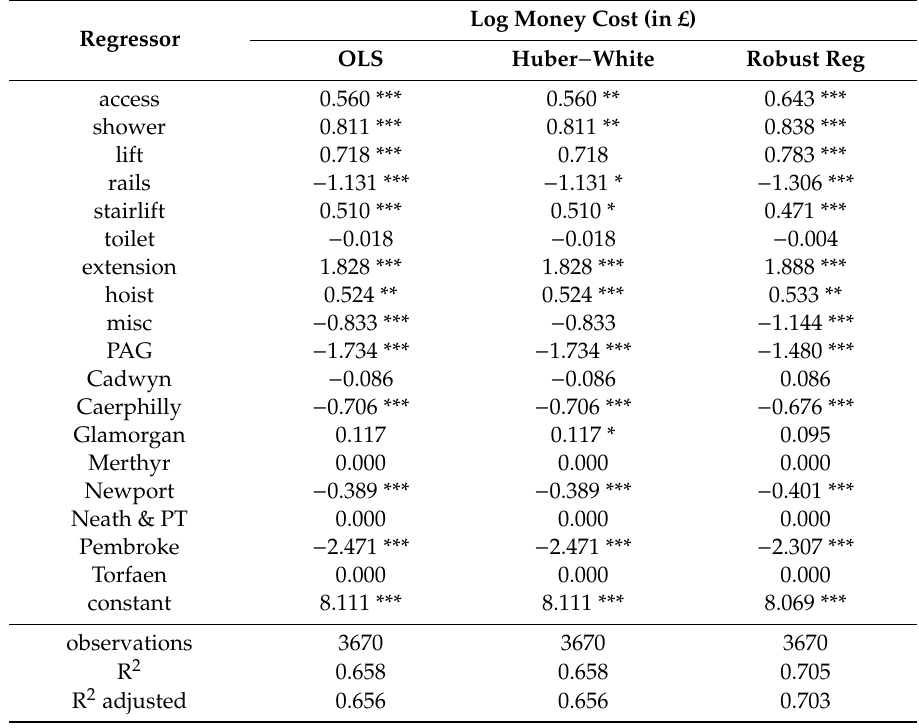
Table notes: the reference location is Bridgend (V2C). * p < 0.05, ** p < 0.01, *** p < 0.001. The second column uses the Huber − White robust estimators of variance. The third column applies an iterative regression procedure to address